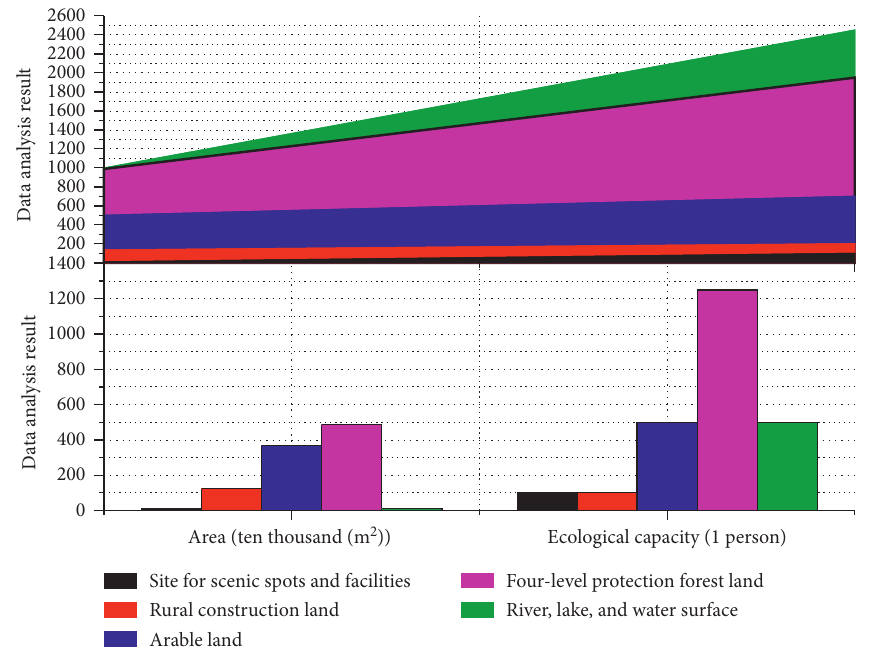
Figure 8: Summary of land area and ecological capacity of the project